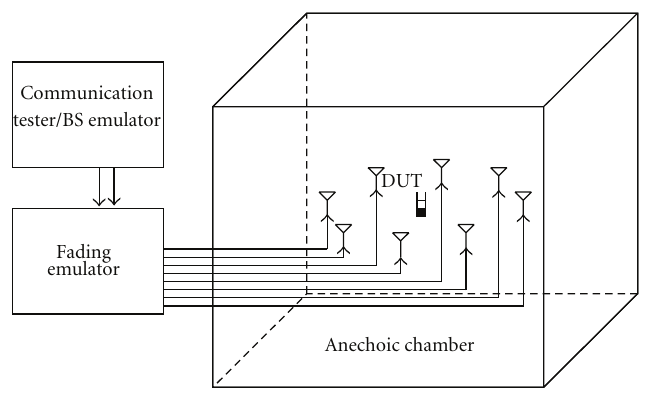
Figure 2: Example of MIMO/Multiantenna OTA test setup (TR 37.976 [7] Figure 6 . 3 . 1 .